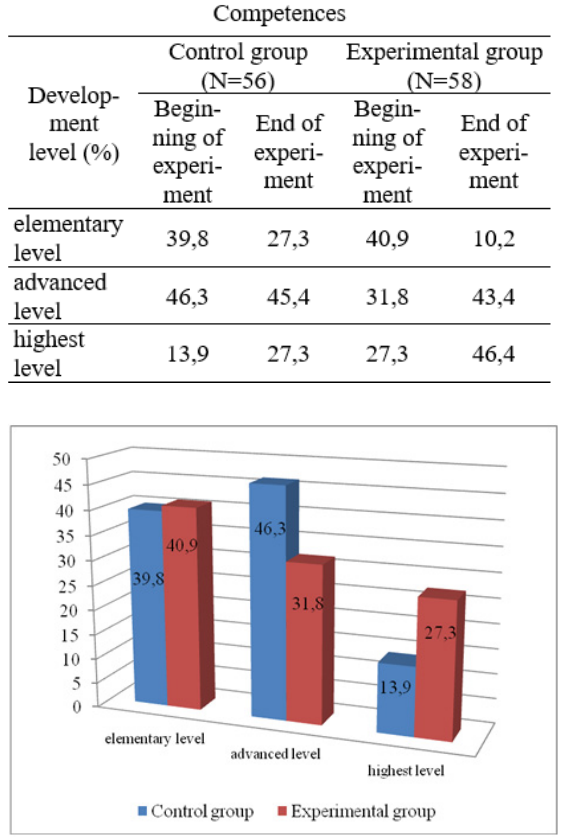
Table 1. Comparison of the findings at the ascertaining and control stages of the experiment